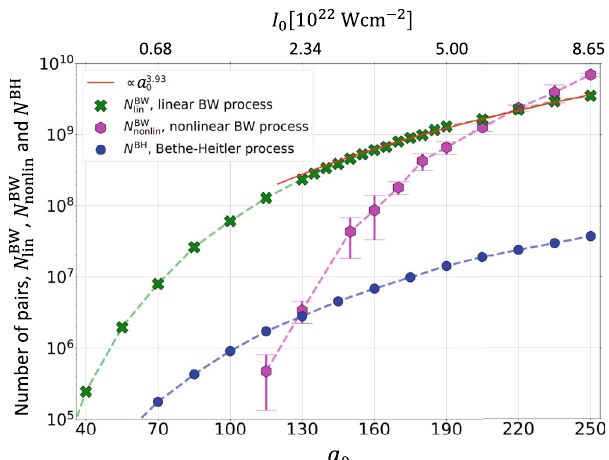
Fig. 6 Number of electron – positron pairs created by the three most important mechanisms. The number of electron – positron pairs created by the linear, N BW , and nonlinear, N BW , Breit – Wheeler processes (green lin nonlin crosses and magenta markers, respectively), for the setup shown in Fig. 1, at given normalized laser amplitude a 0 (and equivalent peak intensity I 0 ). Error bars on the nonlinear results indicate statistical uncertainties (at one standard deviation): see text for details. The estimated background, electron – positron pairs produced by the Bethe – Heitler process, N BH , is shown by blue circles. The nonlinear Breit – Wheeler pair yield is calculated directly by the PIC code, whereas the linear Breit – Wheeler and Bethe – Heitler pair yields are obtained by post-processing, as described in